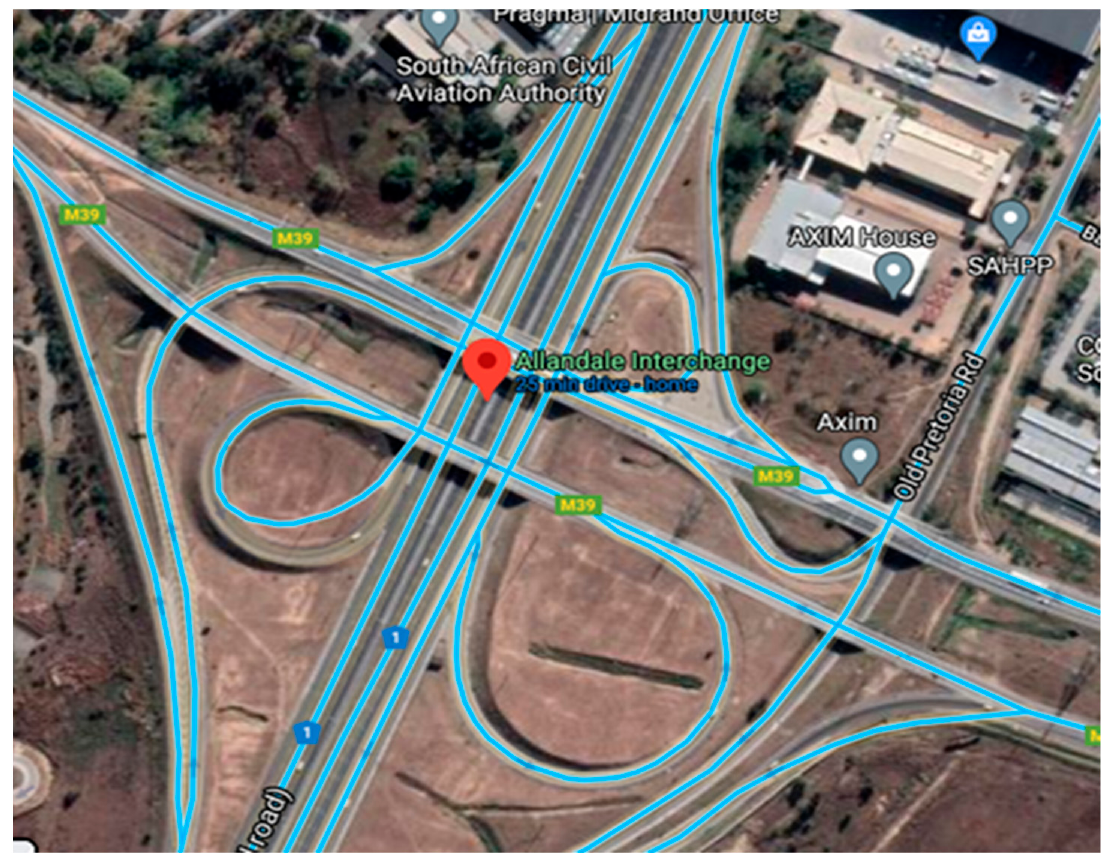
Figure 2. An aerial drone image of the Allandale interchange.